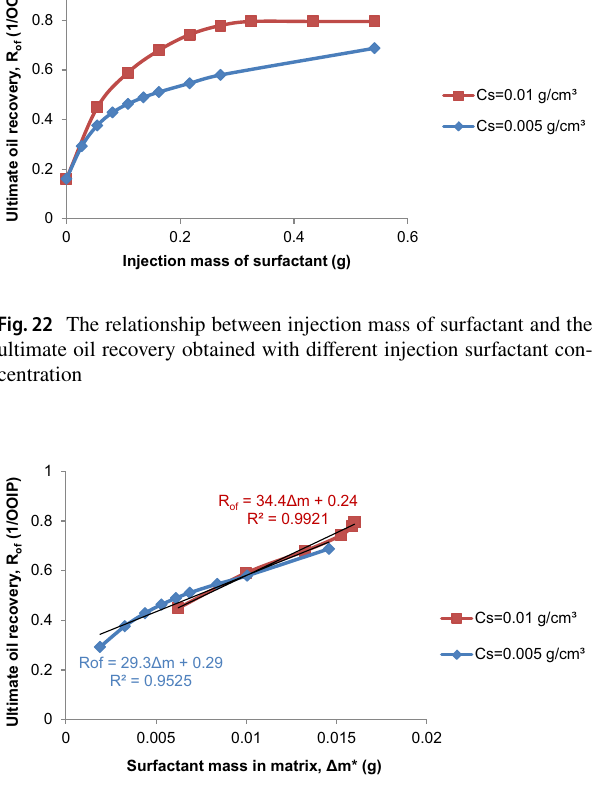
Fig. 23 The relationship between surfactant mass in matrix and the ultimate oil recovery obtained with different injection surfactant con- centration. Δ m * equals to the difference between injected mass of surfactant and the produced mass of